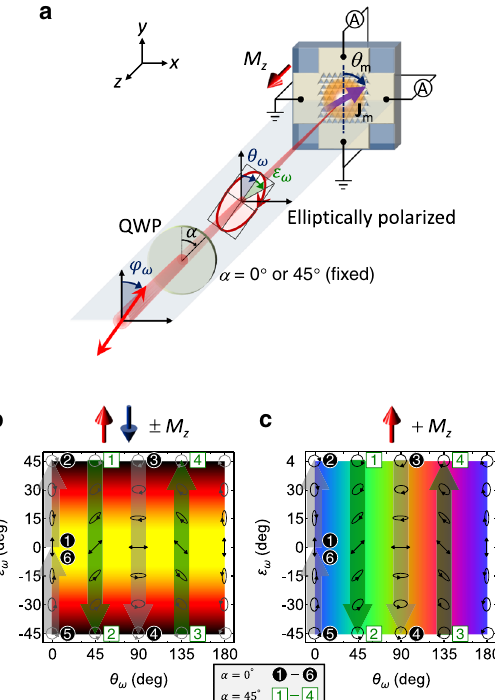
be continuously modulated with θ ω =0°/90° at α =0° and θ ω =45°/135° at α =45°, leadingtothesimultaneouscontrolof ∣ J m ∣ and θ m . d φ ω dependenceof J m, x and J m, y at α =0° (upper panel) and α =45° (lower panel). Shaded (nonshaded) areas cor- respond to θ ω =0° ( θ ω =90°) at α =0° and θ ω =45° ( θ ω =135°) at α =45°. ffiffiffiffiffiffiffiffiffiffiffiffiffiffiffiffiffiffiffiffiffiffiffiffiffiffiffiffiffiffiffiffiffi q ð J Þ 2 + ð J Þ 2 e , ∣ ; J m ∣ = plotted as a function of ε ω . The line is fi tted to (cid:5) (cid:6) m, x m, y (cid:2) 1 J ∣ / cos2 ε ω . Theinset plots θ = J ∣ ; J asafunctionof θ ω .Thelineis m m =tan m, x m, y − 2 θ ω − fi tted to θ m =